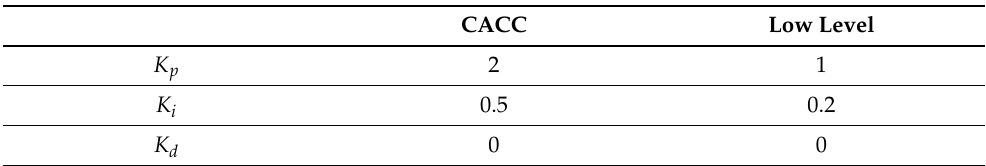
Table 4. PID controllers parameters. Units for CACC controller: K p (1/s), K i (1/s 2 ) and K d (-).